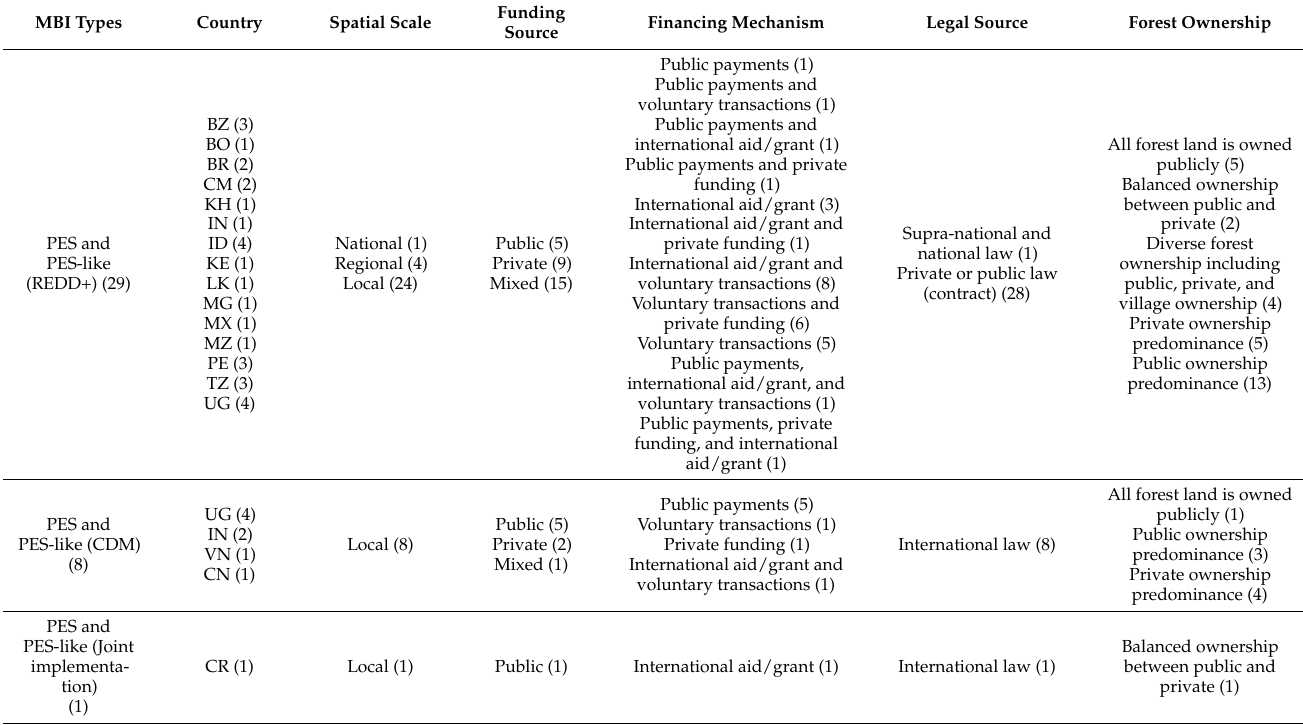
Table 2. Description of policy design features for PES and PES-like schemes identified in the literature review (number in parentheses represents the number of mechanisms with corresponding